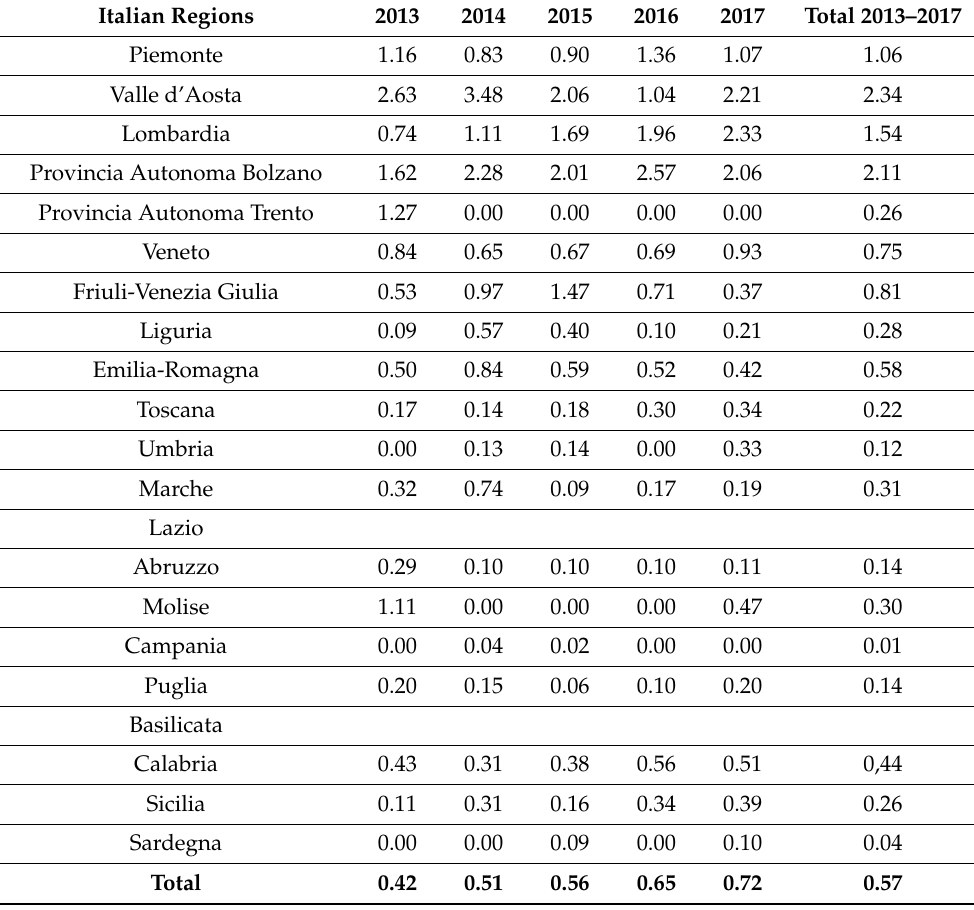
Table 2. Rate per 1000